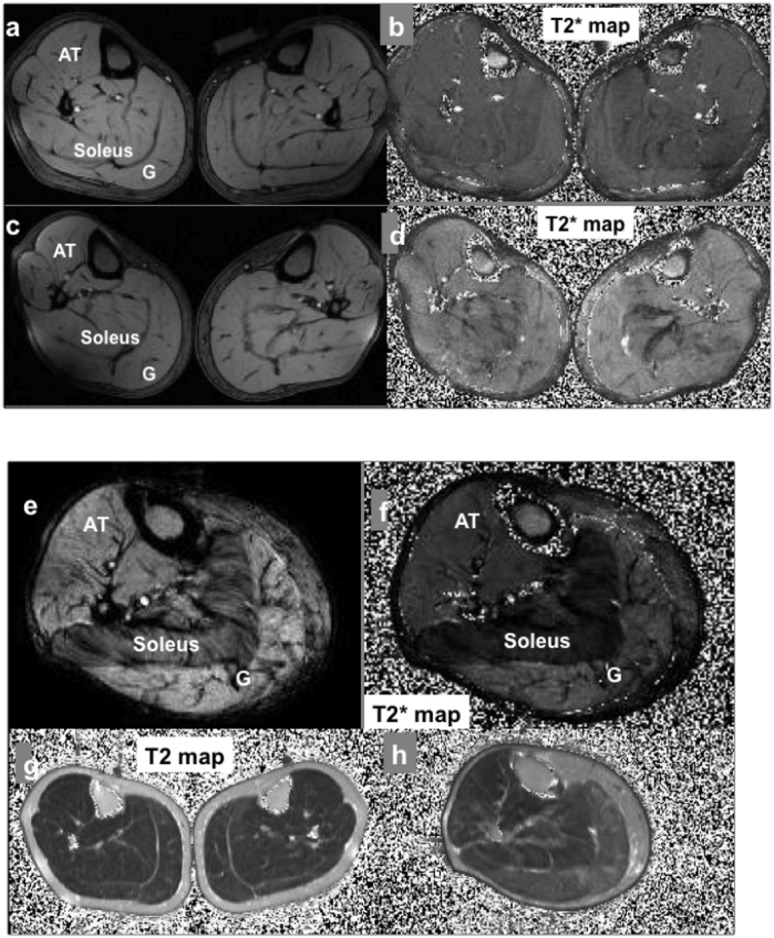
a–f T2* weighted images and T2* maps of calves of a young healthy control (a,b), a 64 year old T2DM subject (c,d), and a 68 year old T2DM subject (e,f) acquired at 3T. g–h representative T2 maps of healthy (g) and T2DM (h) calves. Due to relatively long T2s of the subcutaneous lipid and bone marrow (∼115 ms), the contrast among the muscles was less dramatic than that of T2*.